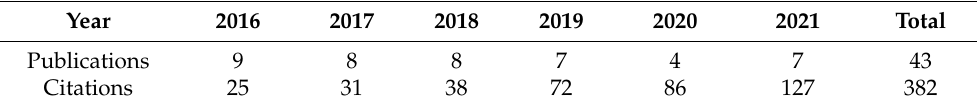
Table 9. Publication and citation counts based on analysis of the pattern: TS = ((solar) AND energy security educ*). Source: Web of Science